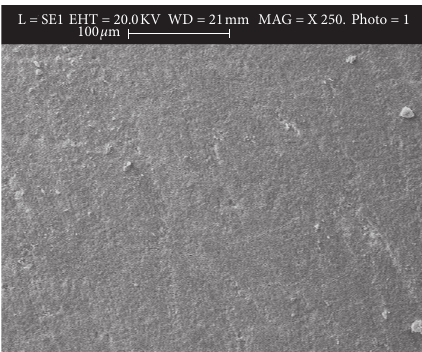
Figure 4: Electro-micrograph showing microporosities with minimal micromechanical retention of adhesive remnants in LC method.